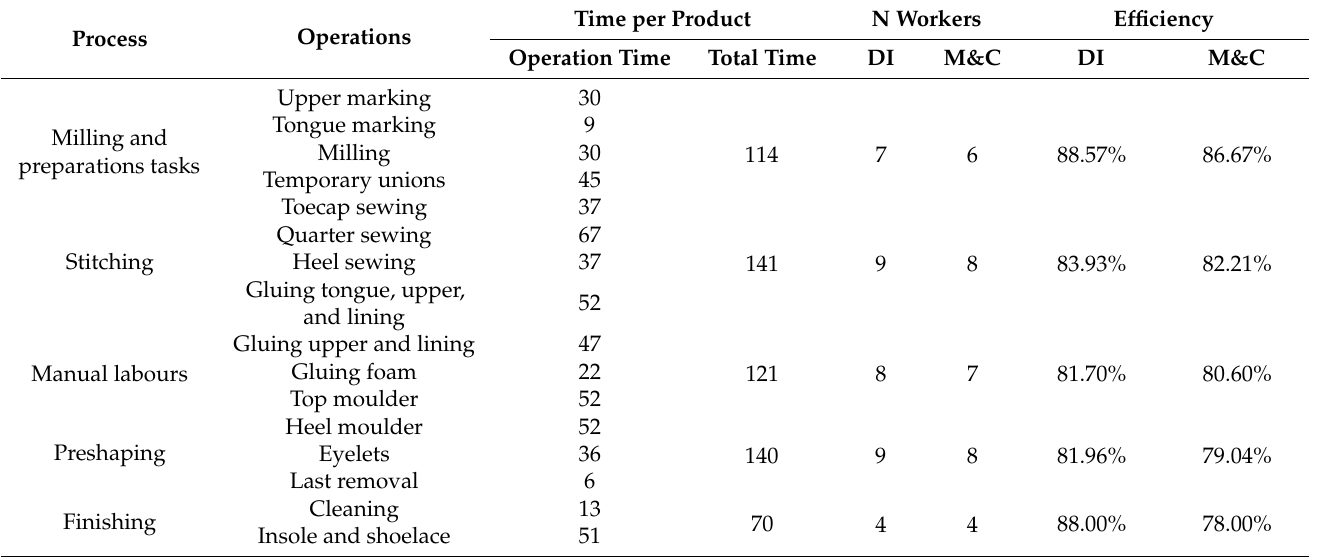
Table 3. Summary of modelled processes. This information is associated with the direct-injection and the mounting-and- cementing process.